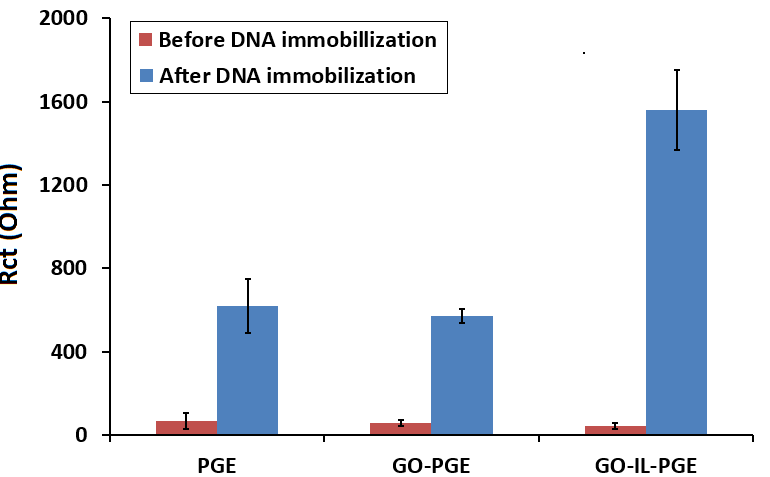
Figure 5. Histograms representing the average R ct values before and after fsDNA immobilization onto the surface of PGE, GO-PGE, or GO-IL-PGE ( n = 3). For better attachment of the DNA probe onto the sensor surface, the effect of 5′ -end modification of the DNA probe was investigated. DNA probes with different 5′ -end mod- ifiers as amino, thiol, or phosphate were used and compared with the unmodified version of the probe (Figure 6). The guanine oxidation signals and RSD % values recorded by the signal with the relatively high increment % was obtained in the case of the amino-linked probe (P 4 ) immobilization. Therefore, NH 2 linkage was approved for effective probe im- mobilization onto the GO-IL-PGE surface.